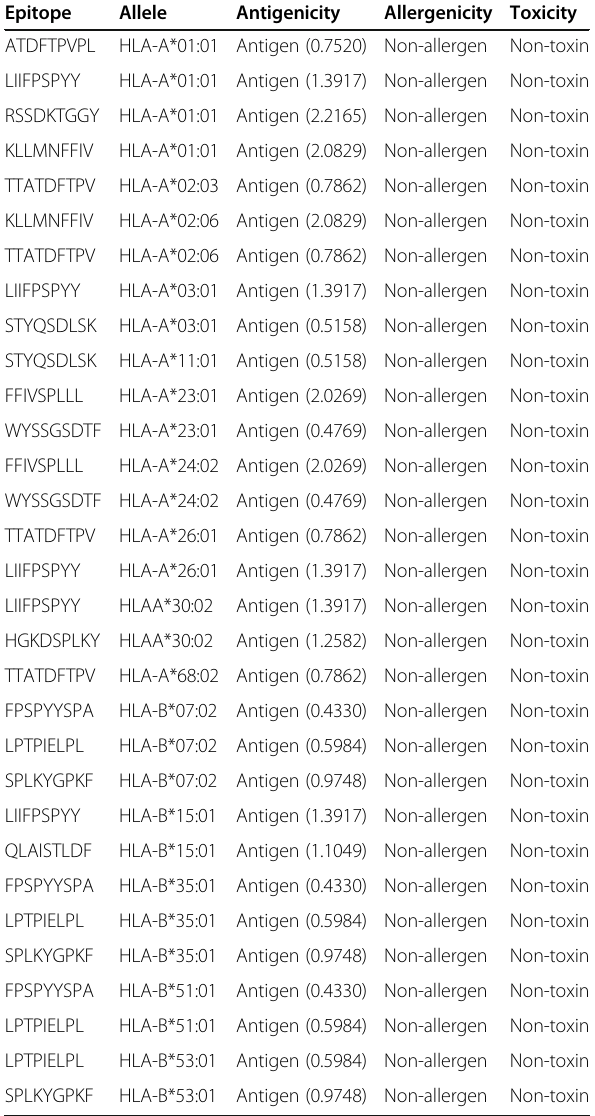
Table 1 Final HLA-I epitopes for vaccine